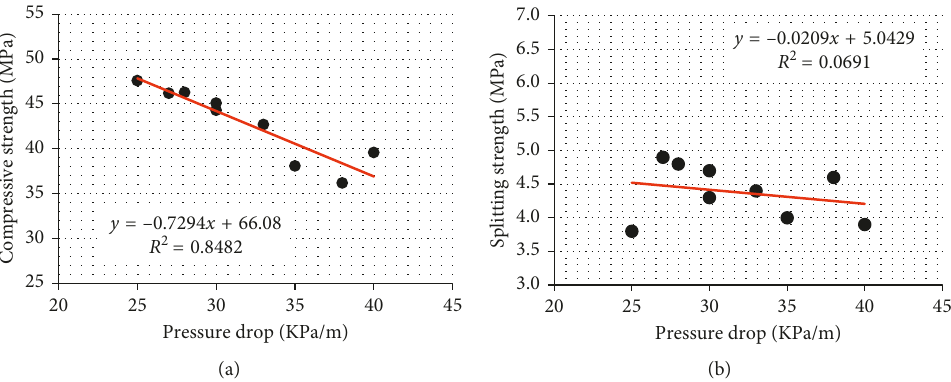
Figure 13: Correlation between pumpability and compressive strength (a) and splitting strength (b).